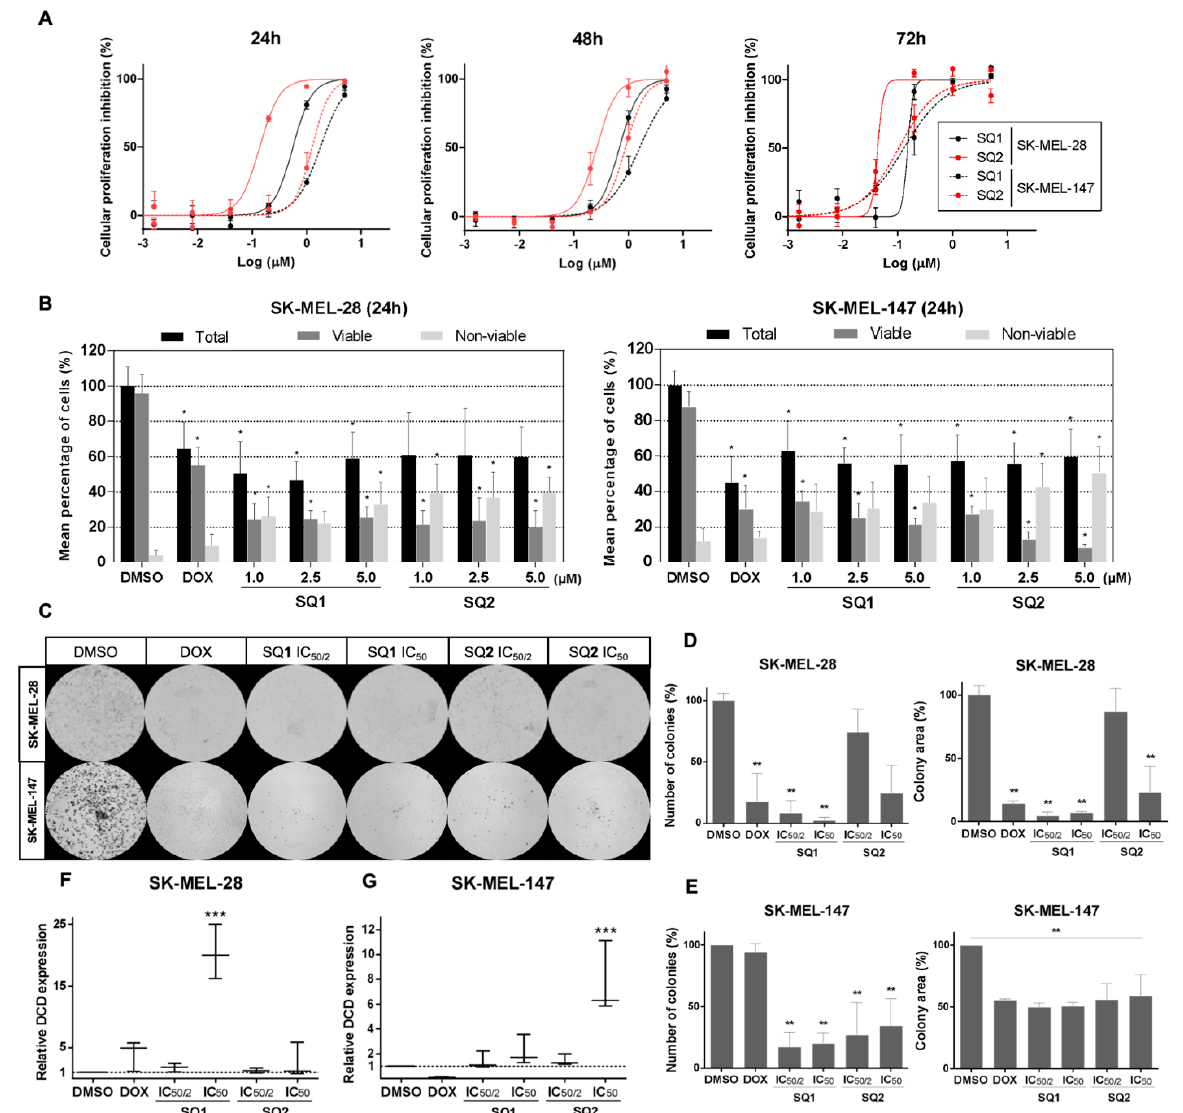
Figure 2 . Characterization of SQ1 and SQ2 activity in BRAF and NRAS mutant cell lines. ( A ) Dose-response curves for SQ1 (black) and SQ2 (red) treatments of SK-MEL-28 (BRAF V600E mutant; full line) and SK-MEL-147 (NRAS Q61R mutant; dotted line) during 24-, 48-, and 72-h treatments. ( B ) SQ1 and SQ2 decreased the percentage of viable cells and increased non-viable cells. SK-MEL-28 and SK-MEL-147 were treated with 1% DMSO (negative control), 10 µM doxorubicin (DOX, positive control), SQ1 and SQ2 (1.0, 2.5, or 5.0 µM) for 24 h. With Trypan blue dye, cells